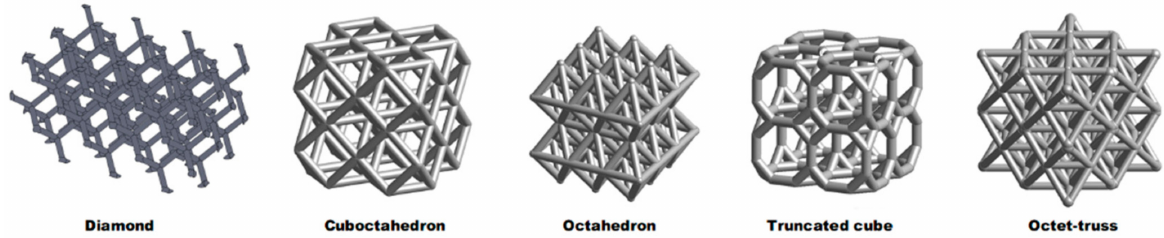
Figure 11. CAD designs of POCS